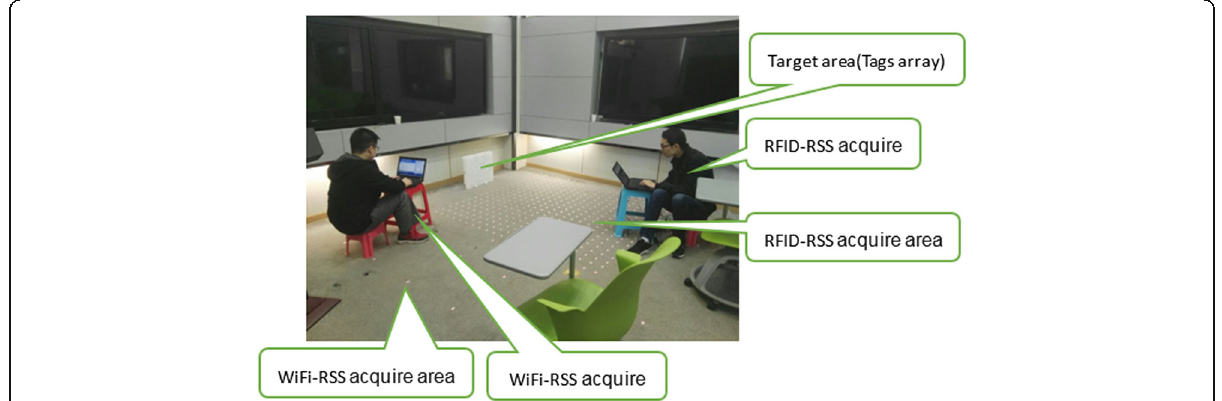
Fig. 4 Electronic tag and ground label layout. The sparse grid is used for AP ’ s RSS acquisition location reference, and the dense grid is tag ’ s RSS collection